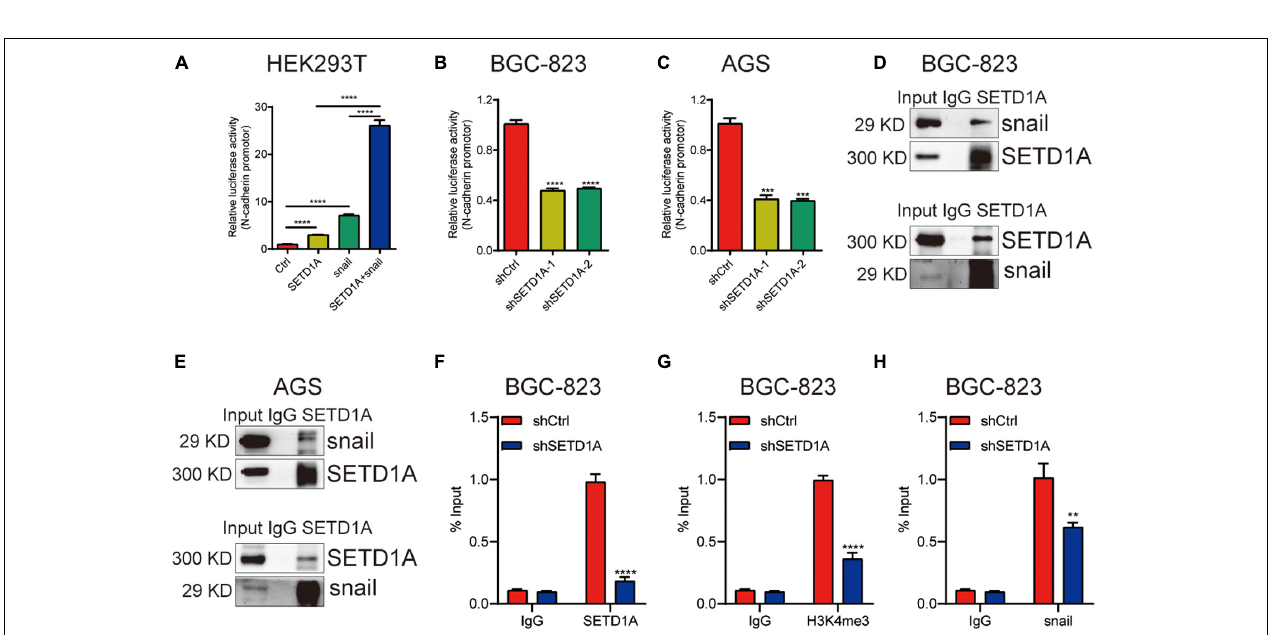
FIGURE 4 | SETD1A induces EMT through coactivation of snail. (A) SETD1A cooperates with snail to enhance the promoter reporter activity of N-cadherin. Data from three replicates are shown as the means ± SD. **** p < 0.0001 by Student’s t -test. (B,C) Downregulation of SETD1A decreases the promoter reporter activity of N-cadherin in BGC-823 and AGS cells. Data from three replicates are shown as the means ± SD. *** p < 0.001, **** p < 0.0001 by Student’s t -test. (D,E) Co-IP analysis of the interaction between SETD1A and snail. Data from three replicates are shown as the means ± SD. (F–H) Downregulation of SETD1A reduced the levels of SETD1A (F) , H3K4me3 (G) , and snail (H) on the promoter of N-cadherin in BGC-823 cells. Data from three replicates are shown as the means ± SD. ** p < 0.01, **** p < 0.0001 by Student’s t